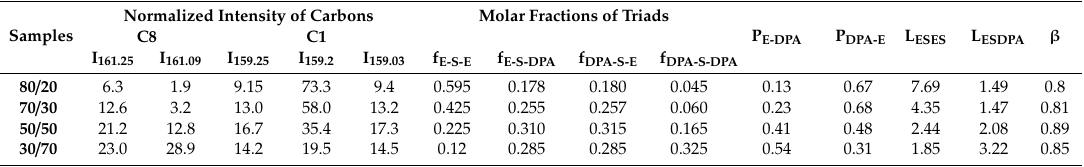
Figure 3. Enlarged section of seven ranges with assignments of the described spectra. Table 3. Normalized intensity of the aromatic quaternary carbon C1 and C8, molar fraction distribution of triads centred on the sulfone (S) moieties, probability of found E next to the DPA units and vice versa, number-average sequential lengths and degree of randomness of the copolymers